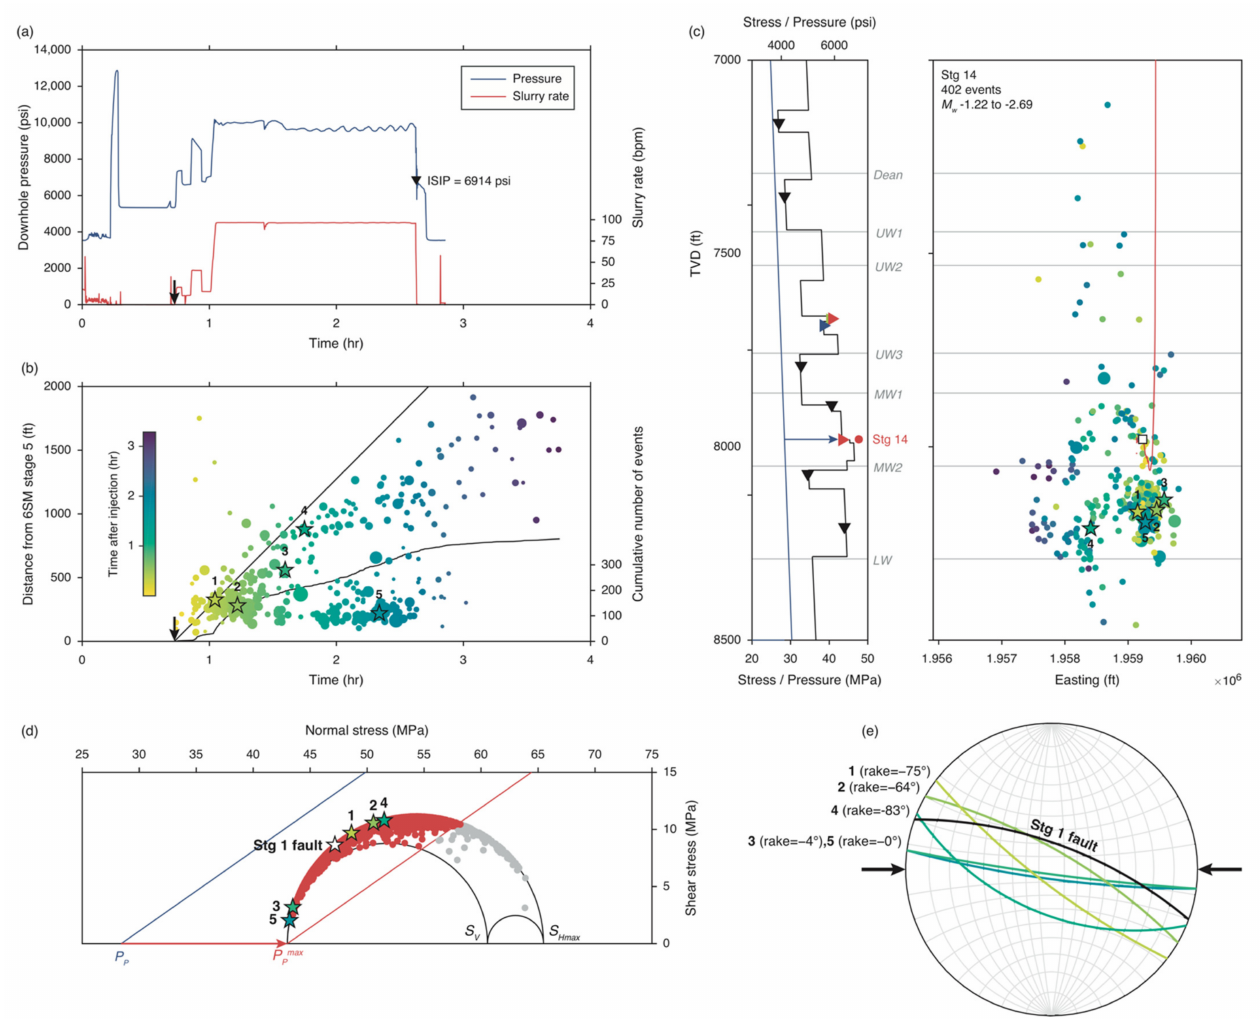
Figure 12. Relationships between stimulation, spatiotemporal distribution of seismicity, and microseismic source mecha- nisms for well 6SM stage 14. ( a ) Pressure–rate–time plot showing the start of injection (black arrow) and the value of the instantaneous shut-in pressure (ISIP). ( b ) Distance–time plot showing earthquakes colored by time after injection and